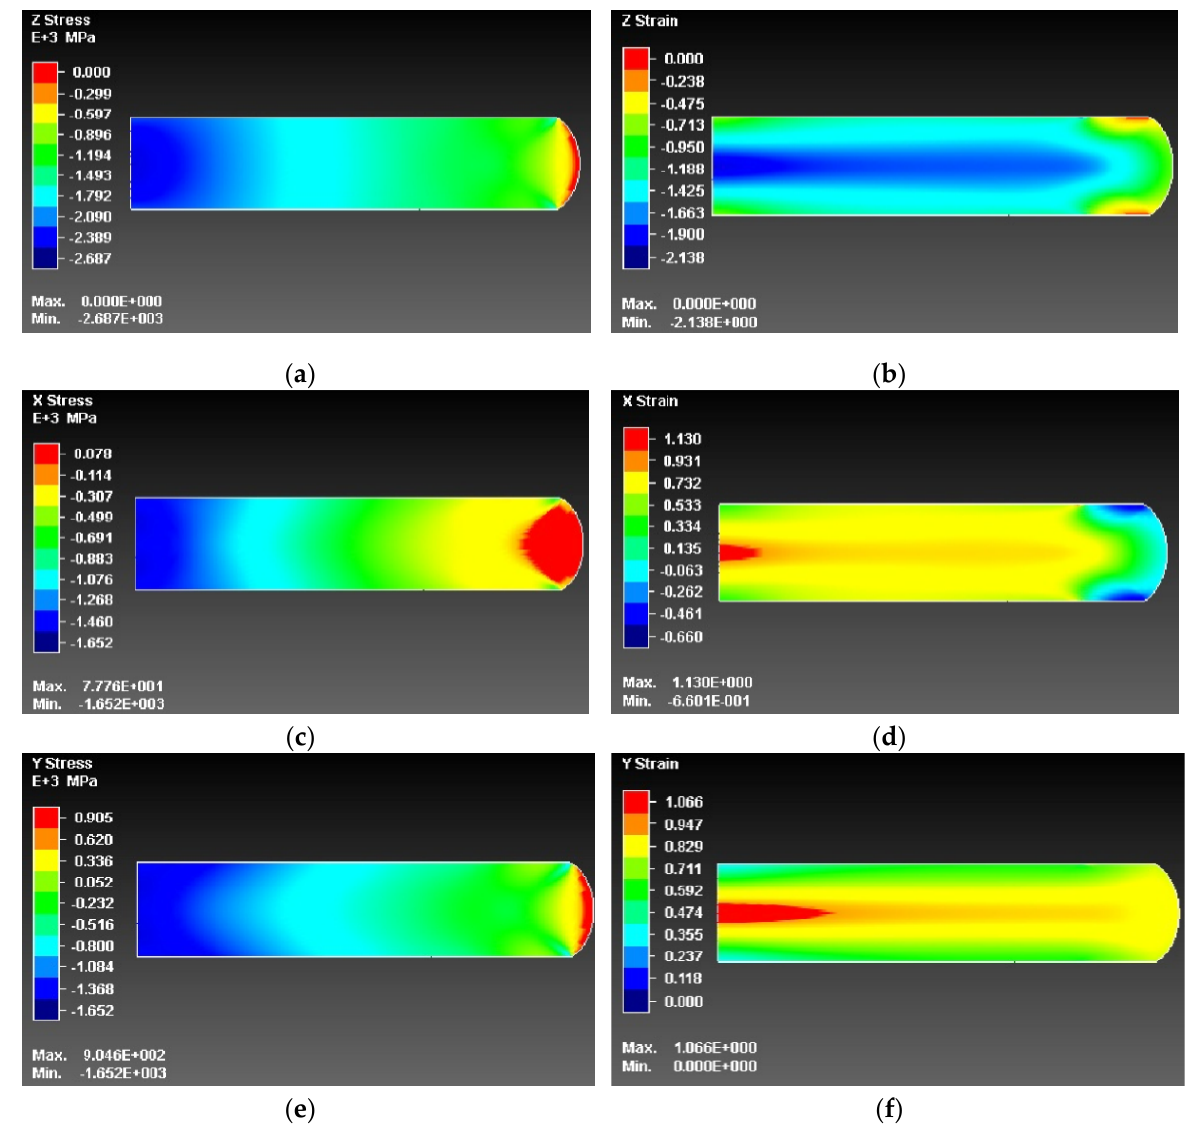
Figure 19. Distribution of stress and strain components for the limiting strain (ε z 4 = 1.59): ( a ) axial stress σ z ; ( b ) axial strain ε z ; ( c ) radial stress σ r ; ( d ) radial strain ε r ; ( e ) circumferential stress σ θ ; ( f ) circumferential strain ε θ